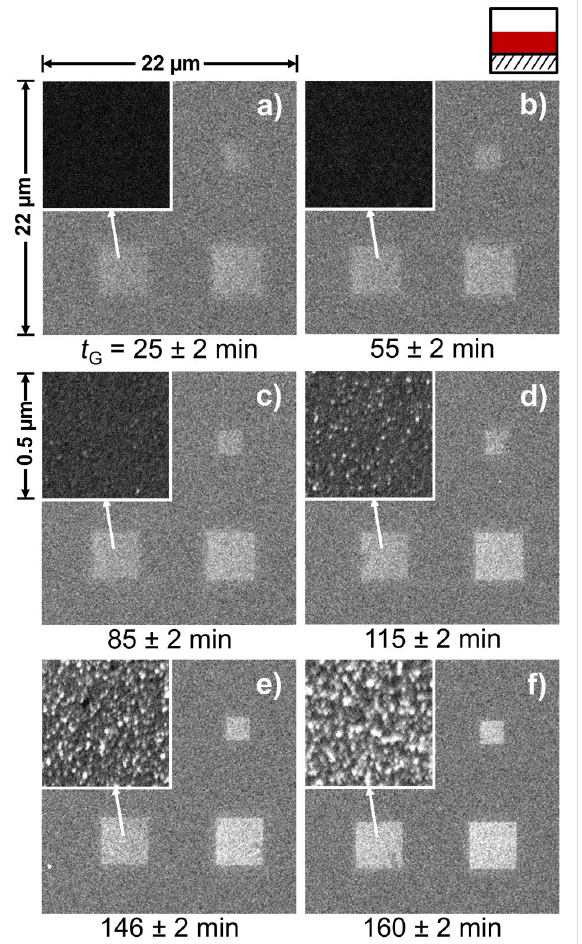
Figure 3: Nanostructures prepared by EBID plus autocatalytic growth using Co(CO) 3 NO on Si 3 N 4 with different growth times, as indicated below the images. The electron dose during EBID was 0.2 C/cm 2 for the structures in the right column of every image; the dose of the lower left square was 0.1 C/cm 2 . The insets show higher magnification images of the respective structures directly below. With increasing growth time the images appear brighter, and the granular nature of the deposits is more